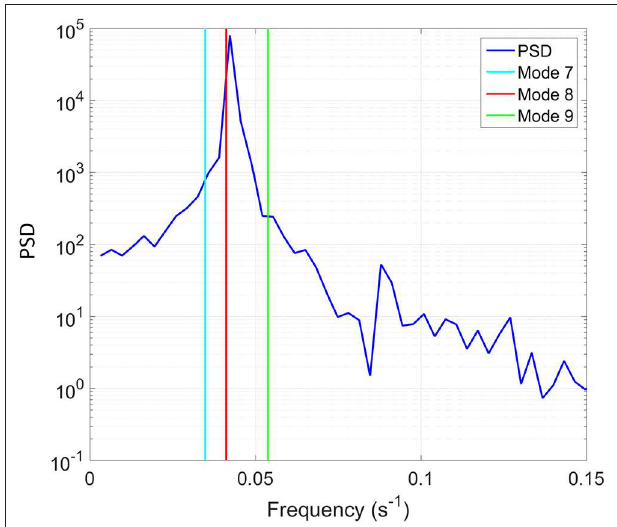
FIGURE 5 | Power spectral density (PSD) of the time record of the interface location shown as function of frequency. In addition, the theoretically-predicted frequencies corresponding to three modes are indicated with the vertical